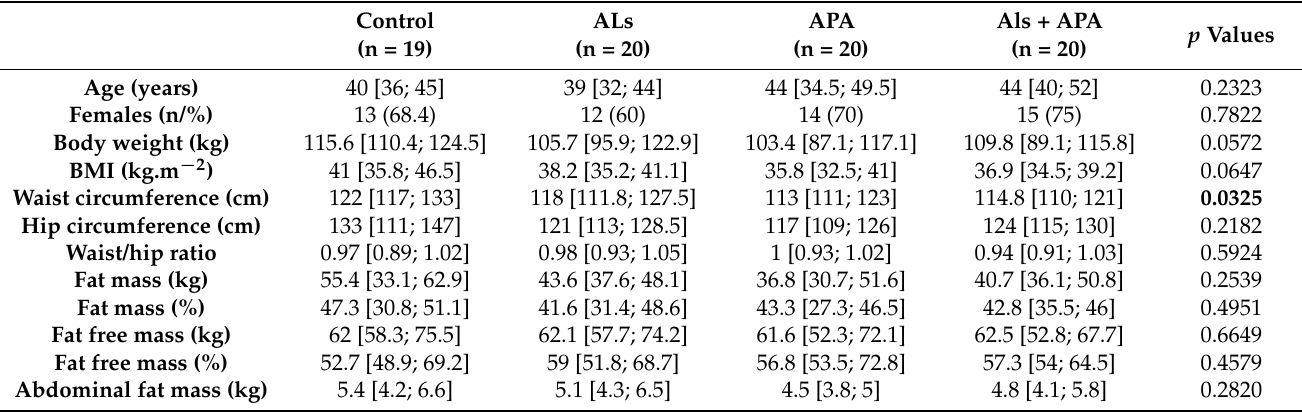
Table 1. Demographic data at